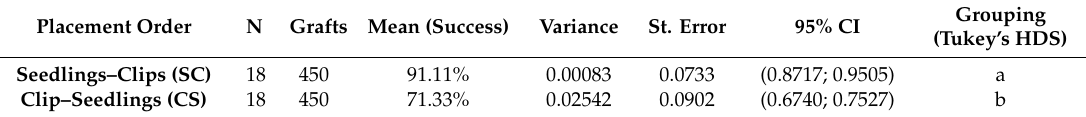
Table 1. Comparison between success averages tested for different placement orders. Grouping of